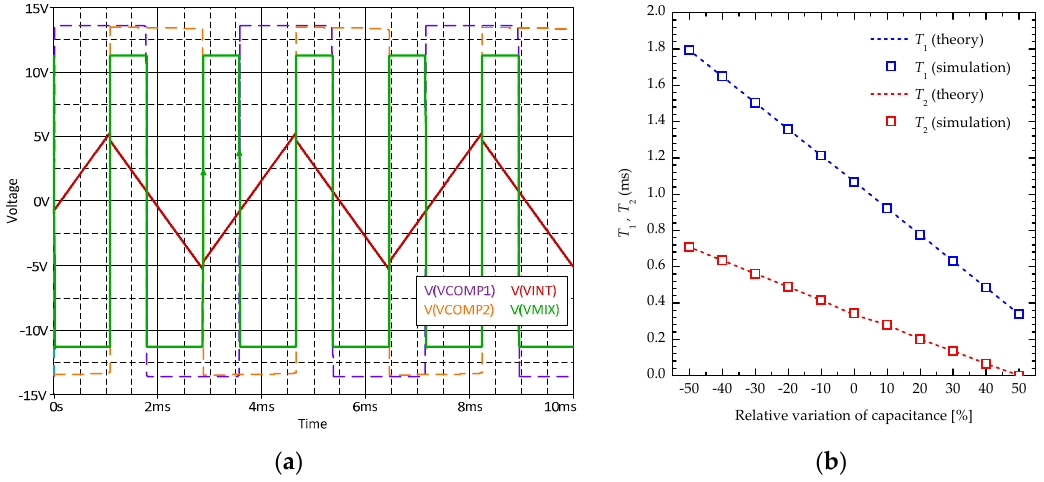
Figure 4. ( a ) Example of the time response of the circuit; and, ( b ) simulation results together with the corresponding theoretical data of the period T 1 and the pulse width T 2 of output square waveform V MIX as a function of the relative variation the differential capacitive sensor for C 1 = C 2 = C 0 = 10 pF.